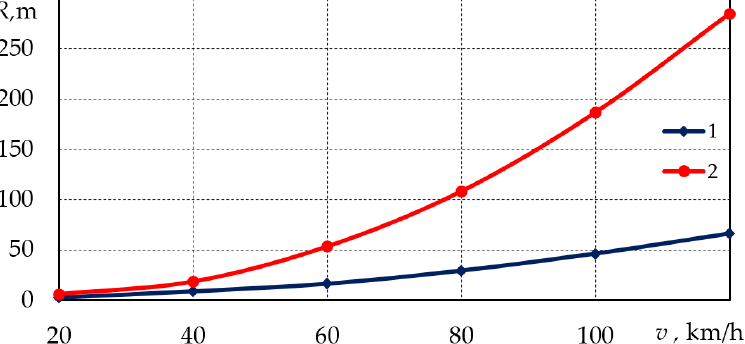
Figure 29. Dependence of the boundary turning radius on the vehicle speed with (1) and without (2) the distribution of radial loads, and the change in wheel position during deformation of the suspension.